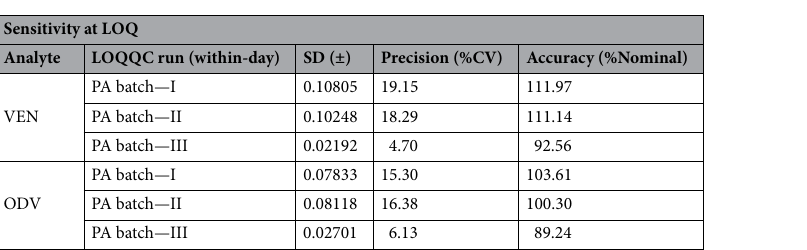
Figure 6. Representative chromatogram of LOQQC of ( a ) venlafaxine and ( b ) O -desmethylvenlafaxine.